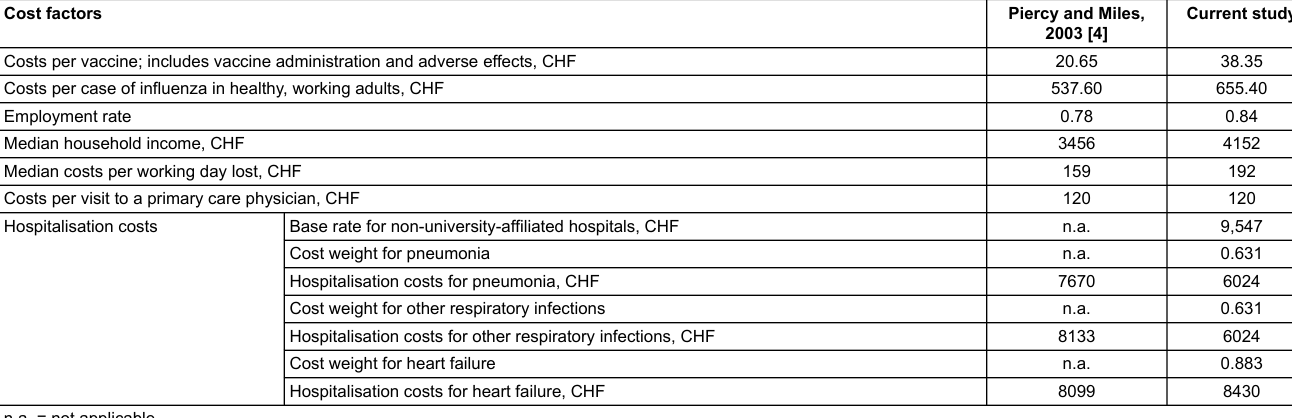
Table 1: Parameters for estimating the economic benefits of influenza vaccination and the economic loss due to influenza in the 2017/18 influenza season. Cost